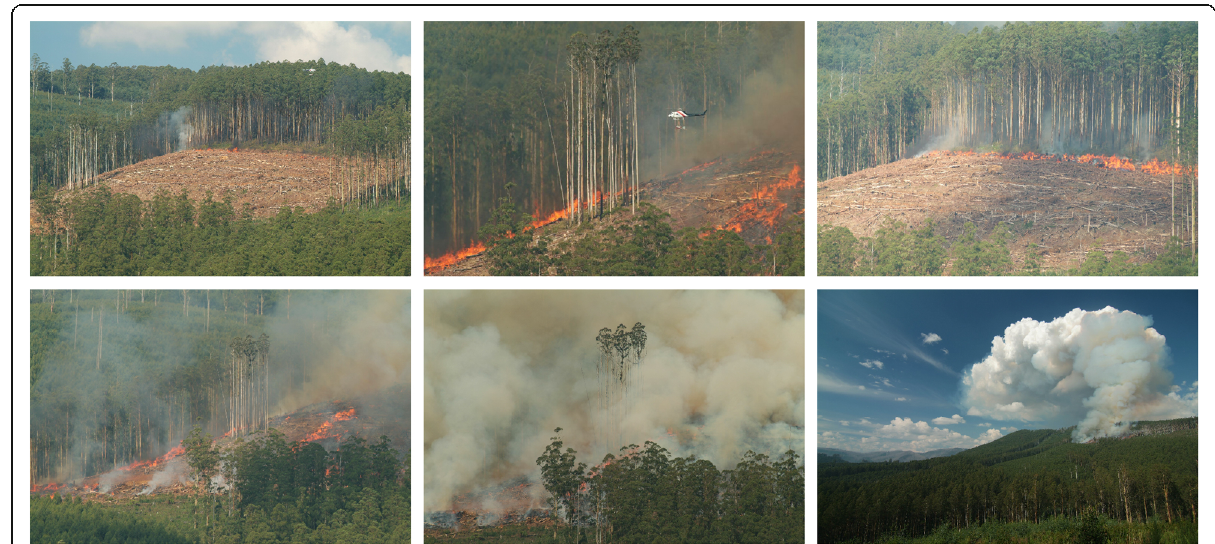
Fig. 3 Logging slash on the floor of a harvested forest is burned in a high-intensity regeneration fire. The island retained within the logging coupe (top center) is unfortunately burned and all retained trees killed so they cannot grow to become large old trees as is the intention of such retention. Notably, the third image (top right) in this sequence shows the regeneration fire burning under the retained trees at the top of the logging coupe; the fire subsequently escaped the boundaries of the logging coupe and burned into the adjacent water catchment forest (after Lindenmayer et al.